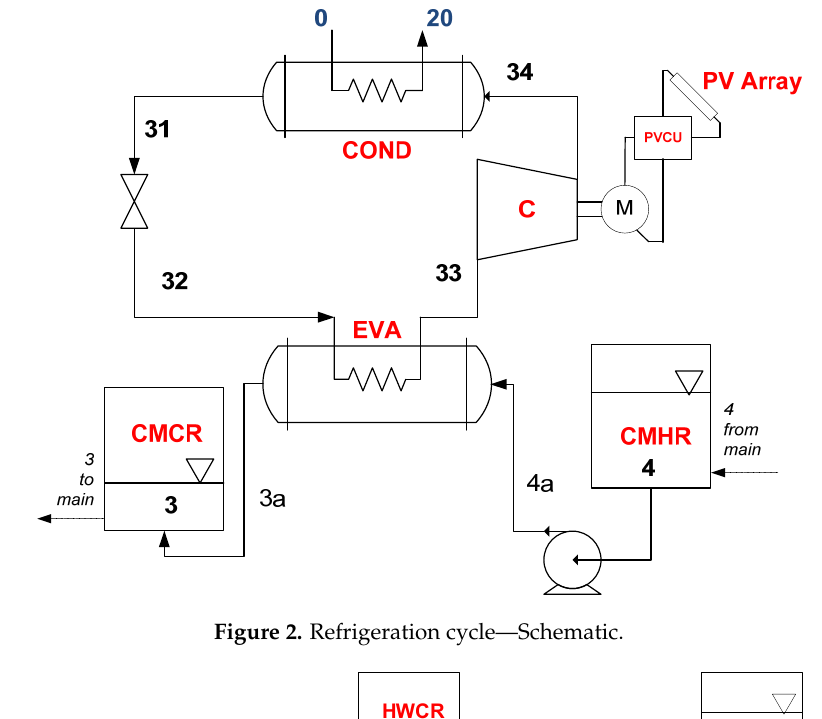
Energies 2019 , 12 , x Figure 2. Refrigeration cycle—Schematic. Figure 2. Refrigeration cycle—Schematic.